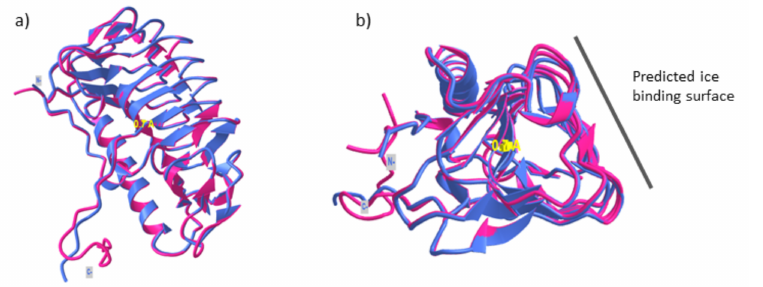
Figure 3. ( a ) Superimposition of GaAFP4 predicted structure (magenta) and LeIBP (PDB id: 3UYU) (purple) with RMSD value 0.7 Å. The structure showed a typical β -helical fold as reported in other fungal AFPs. ( b ) Predicted ice-binding surface of